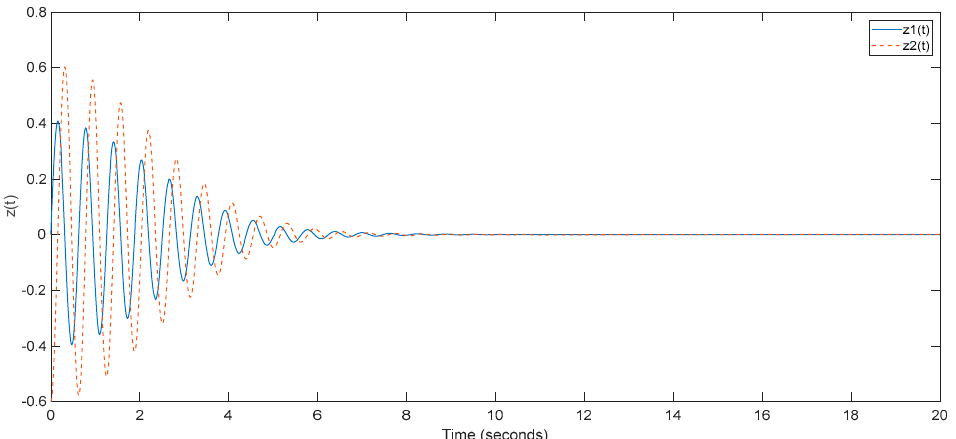
Figure 2. Regulated output for arbitrary switching signal and no control input.